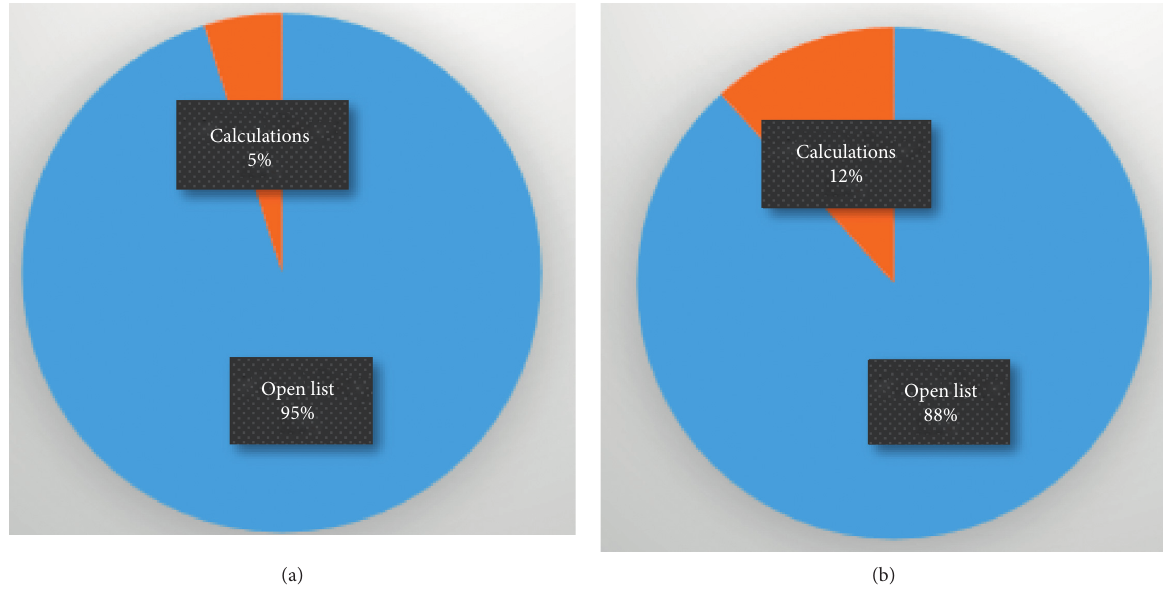
Figure 2: Execution time of software code. (a) The software runs in a single thread. (b) The software runs in 8 threads.